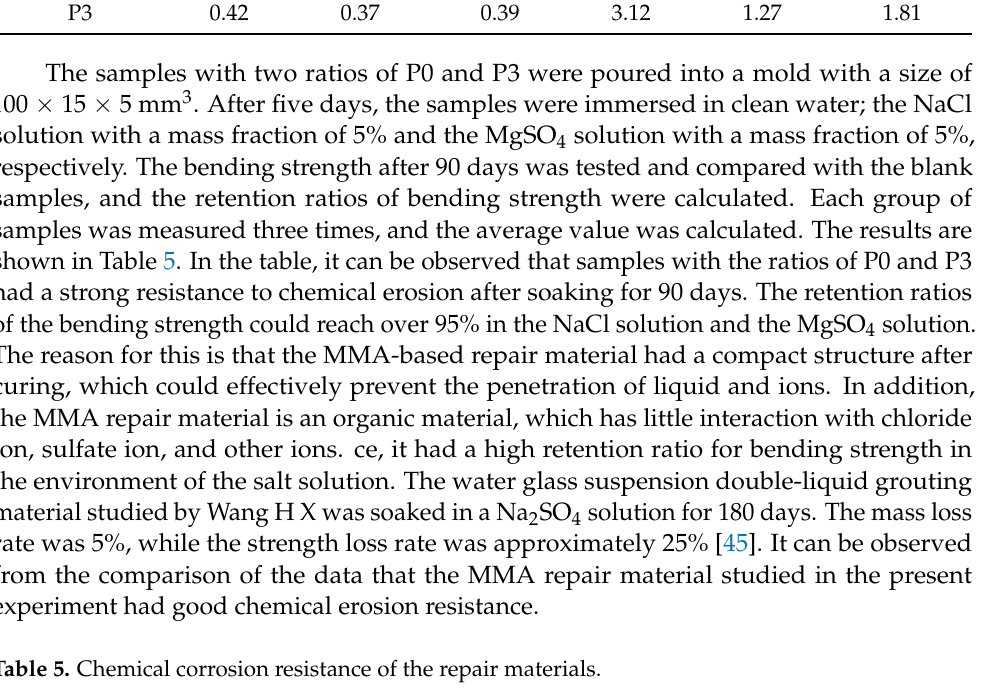
Table 5. Chemical corrosion resistance of the repair materials.